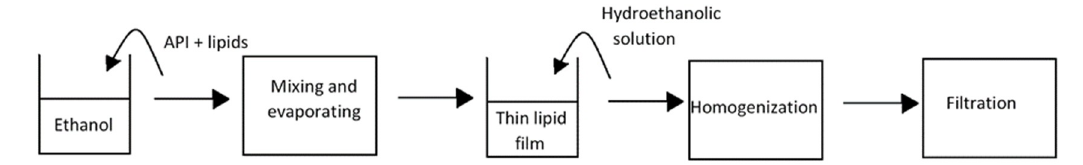
Figure 6. The classic method of mechanical dispersion.